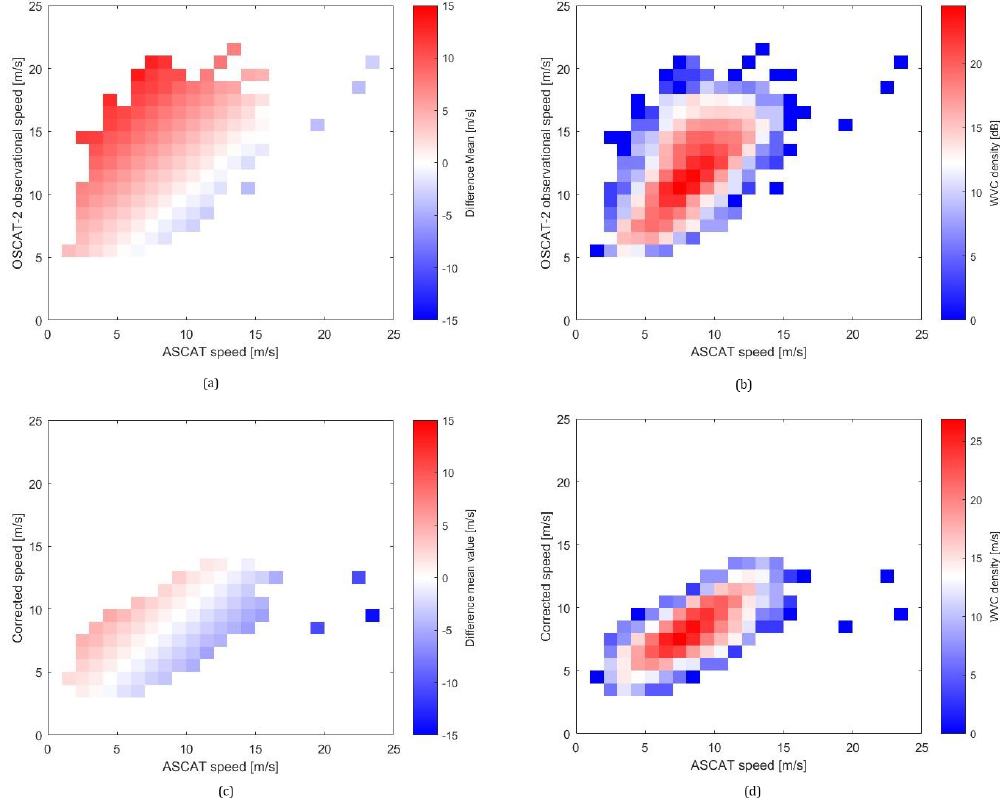
Figure 5. Mean values in 1m/s bin of winds against mean difference values in the same bin of vertical minus horizontal values (colour) (a) and (c) , and sample WVC density (b) and (d)